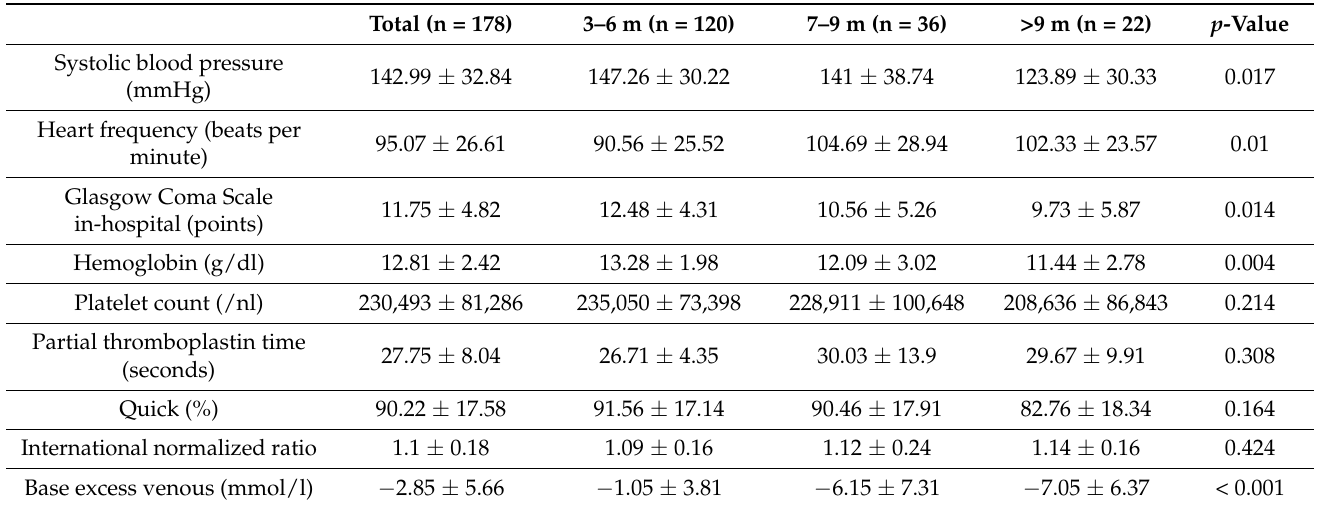
Table 2. Vital parameters and laboratory parameters at admission sorted by the altitude of the fall. Total (n = 178) 3–6 m (n = 120) 7–9 m (n = 36) >9 m (n = 22) p